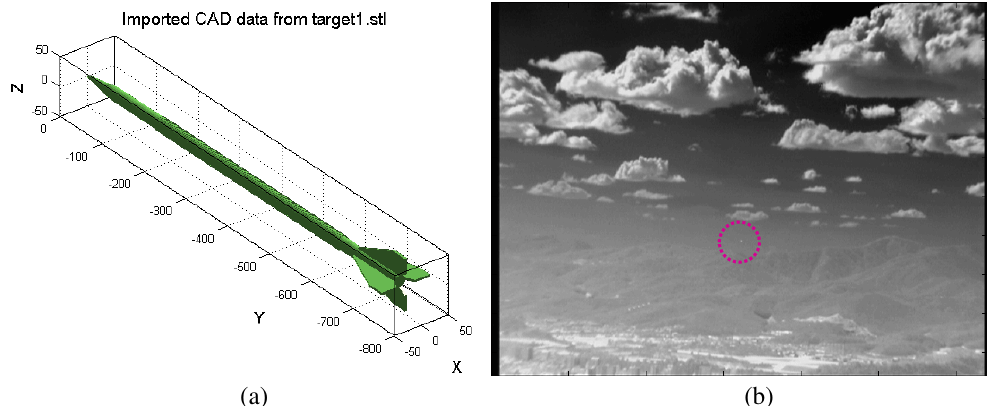
Figure 20. Test DB generation by inserting 3D CAD model into a real IR sequence: ( a ) 3D target CAD model; ( b ) synthesized result: target distance 1.2 km, target radiation: 50